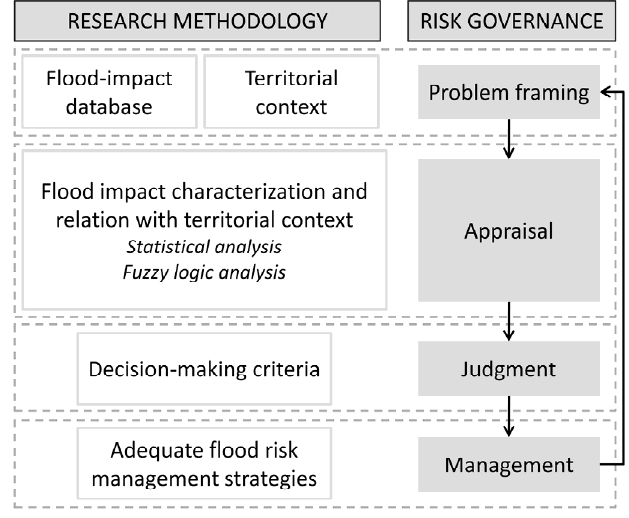
Figure 11. Risk management framework of the study methodological